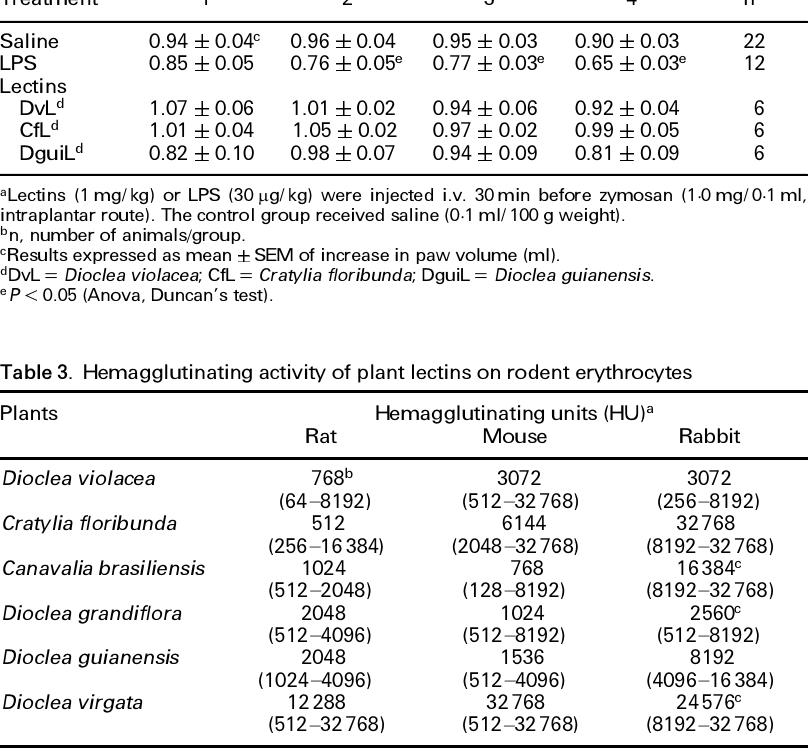
Table 2. Effect of plant lectins and LPS on the time course of paw oedema induced in rats by zymosan Treatment a